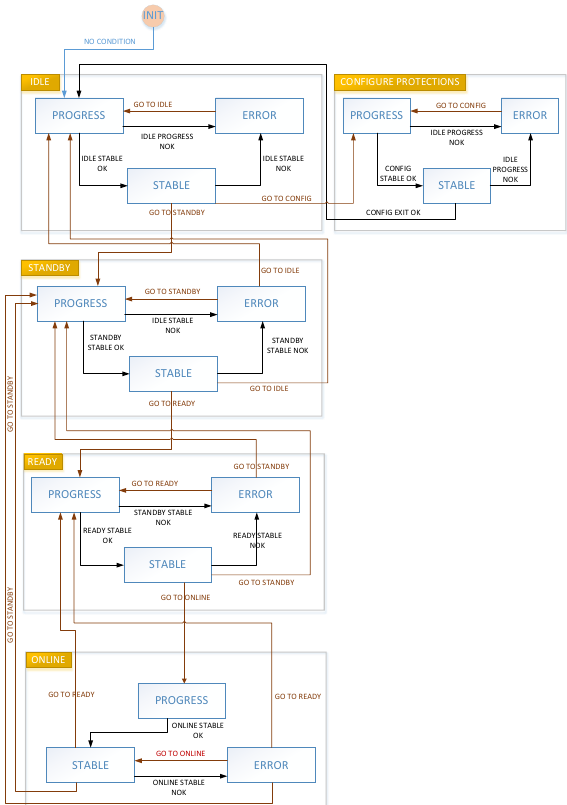
Fig. 2. ECPC State